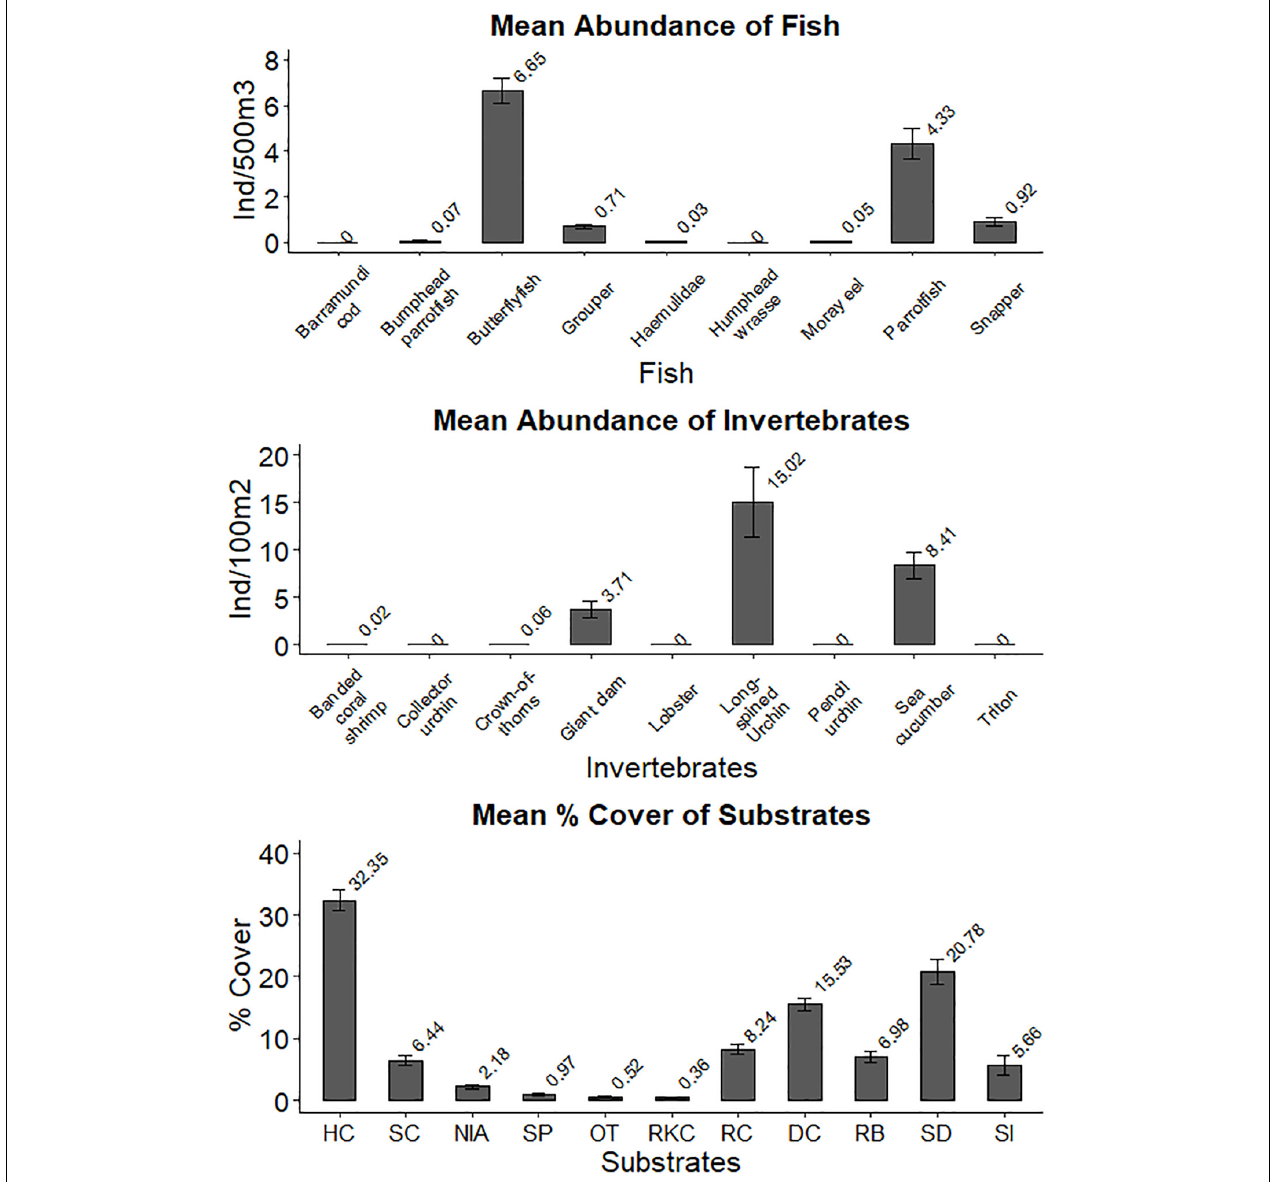
FIGURE 2 | Mean abundance (mean ± SE) of all Reef Check indicators for fish (individual/500 m 3 ) (top) , invertebrates (individual/100 m 2 ) (middle) and percentage coverage (mean ± SE) of Reef Check substrate categories (%) (bottom) for Pulau Tioman ( n =